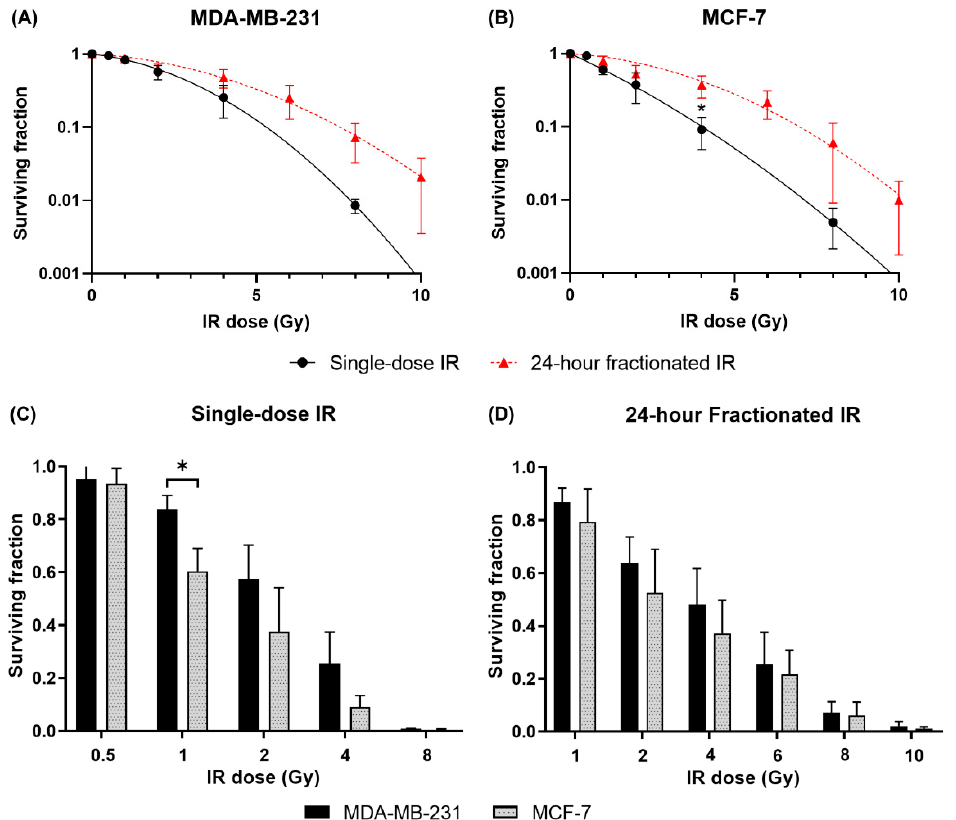
Figure 3. IR dose fractionation leads to decreased lethality, and MCF-7 cells are more radiosensitive than MDA-MB-231 cells. Clonogenic assays were performed to quantify cell survival after treatment with either a single-dose IR or 24-h fractionated IR at total doses of 0.5 to 10 Gy. Surviving fractions of ( A ) MDA-MB-231 and ( B ) MCF-7 cells were fitted to graphs using the linear-quadratic model. The effects of ( C ) single-dose and ( D ) 24-h fractionated IR on the cell lines were then compared. Data are shown as mean ± SD of three independent experiments performed in duplicate or triplicate wells. * p < 0.05 difference between single-dose and fractionated survival.